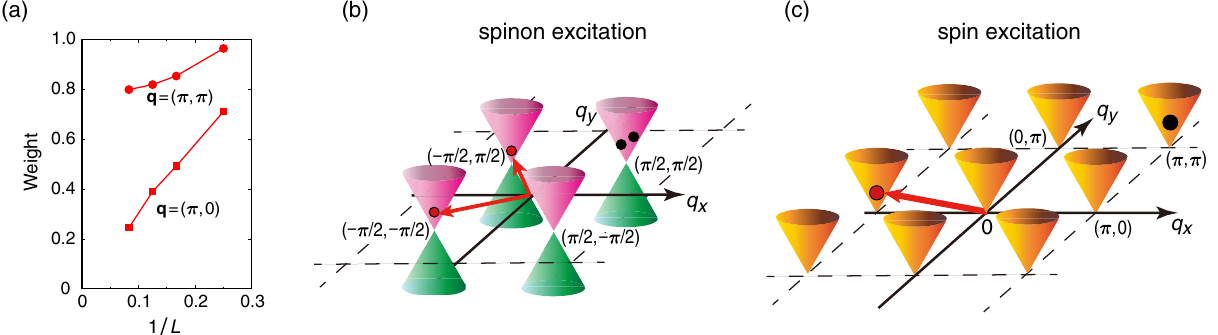
FIG. 6. (a) Weight of lowest branch in the dynamic spin structure factor for q ¼ ð π ; 0 Þ and ð π ; π Þ for J 2 =J 1 ¼ 0 . 5 . At each q point, the R ∞ d ω S q ; ω Þ . (b) Schematic picture for plausible spinon dispersion around gapless weight is normalized by the total spectral weight s ð 0 points ð(cid:2) π = 2 ; (cid:2) π = 2 Þ , illustrated both for particle (pink) and hole (green) sides above and below the spinon Fermi energy. Two examples of two spinon excitations (two red and two black circles) are illustrated (see below). (c) The observable spin excitation is constructed from the two spinon excitations, which generates the gapless points at ð π ; 0 Þ , ð 0 ; π Þ , (0,0), and ð π ; π Þ . For instance, the red circle with the momentum around ð − π ; 0 Þ is constructed from the two spinon excitations shown as the small red circles with the momenta around ð − π = 2 ; π = 2 Þ and ð − π = 2 ; − π = 2 Þ in (b). The black circle is another example of spin excitation originated from the two spinon excitations shown as the small black circles in (b). Continuum incoherent spin excitations inside the cones are generated from the combinations of the two spinon excitations on the pink or green cone surfaces in (b).